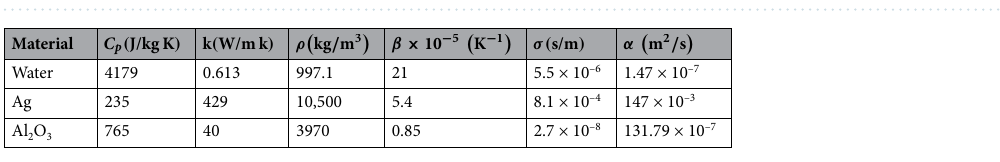
Figure 1. Schematic diagram of the physical model in ( a ) 2D and ( b ) 3D.